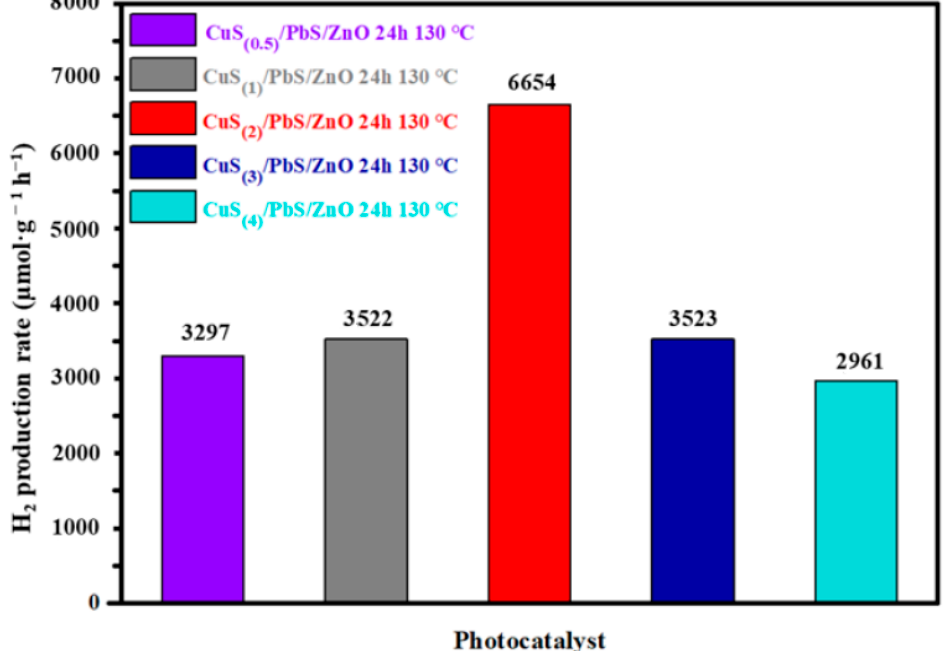
Figure 7. Rate diagram of hydrogen production on PbS/ZnO loaded with different contents of CuS NPs .